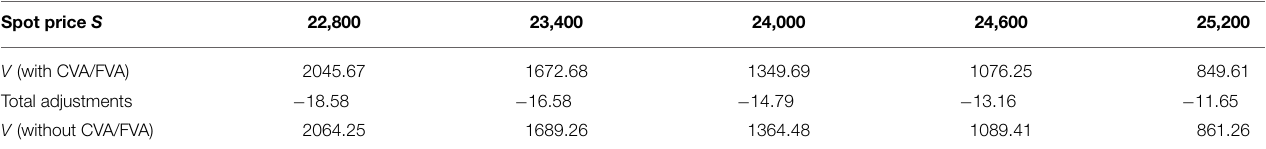
TABLE 3 | Prices of European put under KoBoL process as of 9 January 2015, time to maturity T = 0 . 463 , strike K = 24 , 000 , risk-free rate r = 0 . 52 % , collateral rate r